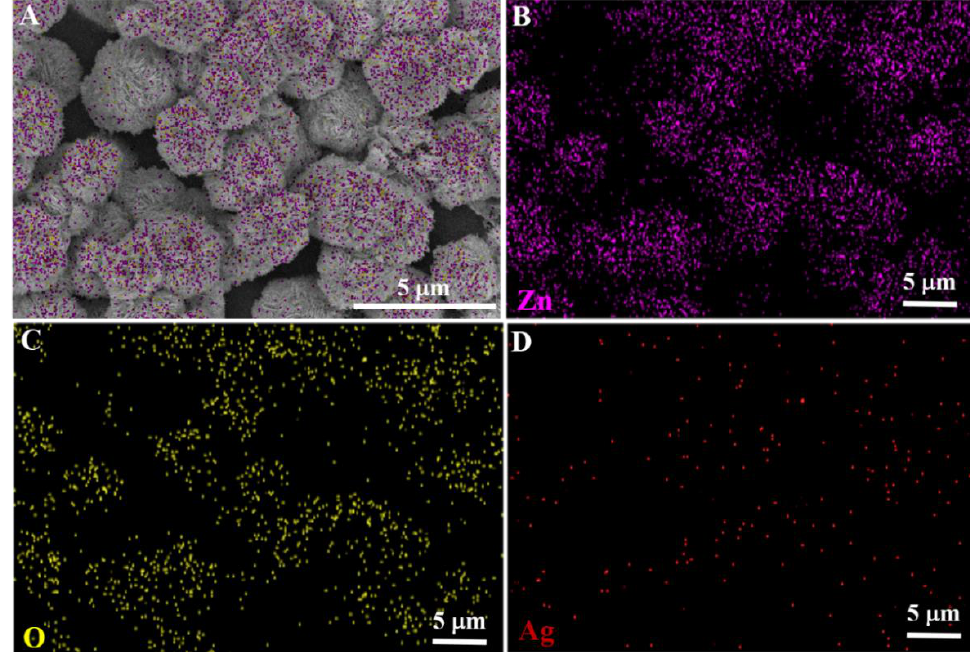
Figure 3. SEM of Ag-3/ZnO ( A ); corresponding elemental mapping of zinc ( B ), oxygen ( C ), and silver ( D ).